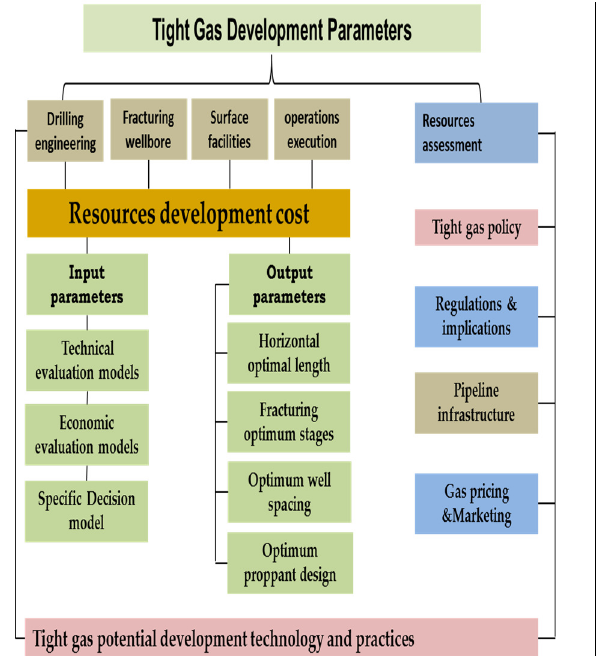
Fig. 5: Key Considerations for Tight Gas Potential